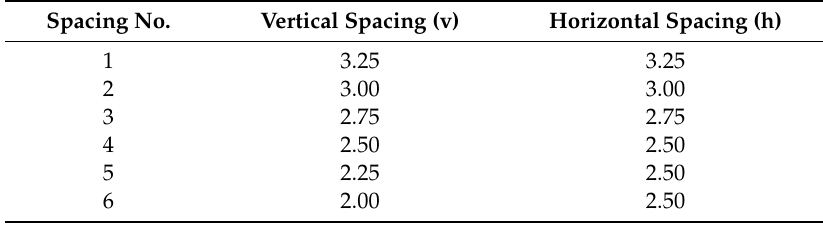
Table 1. Spacing between motors